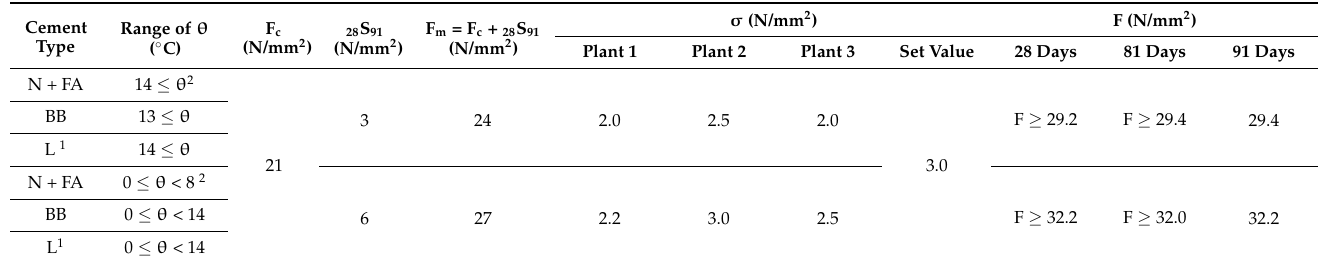
Table 11. Example of mix proportion strength